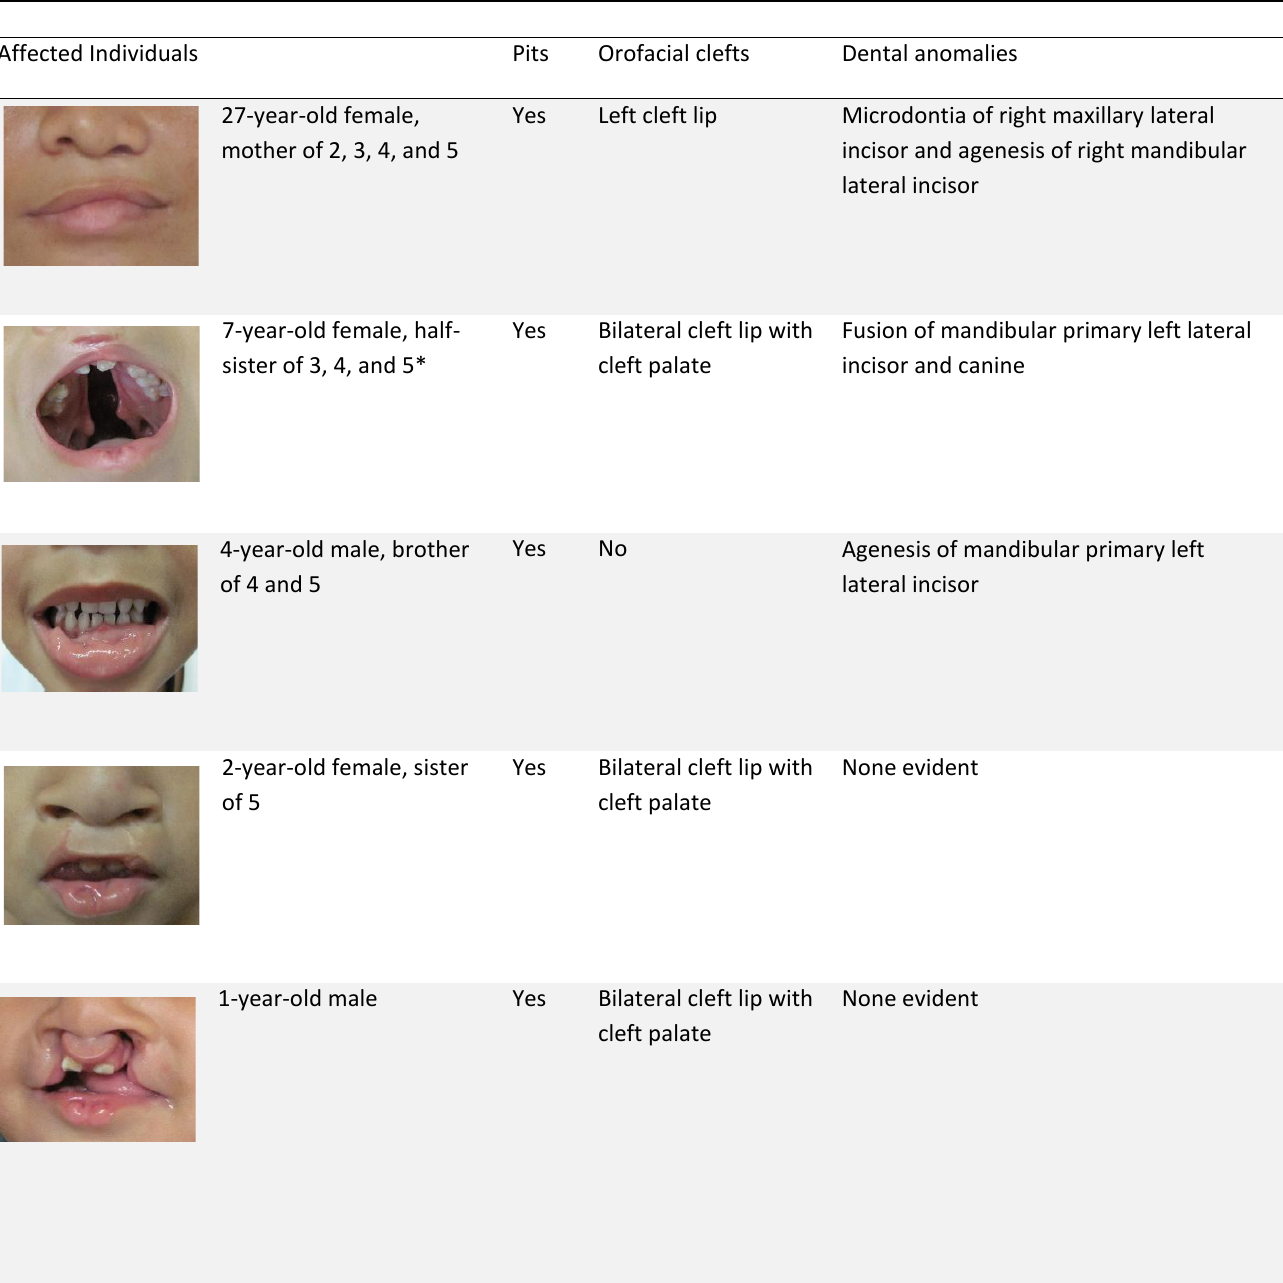
Table 2. Phenotype variation of Individuals with IRF6 Ser90Thr variant and Van der Woude syndrome. Affected